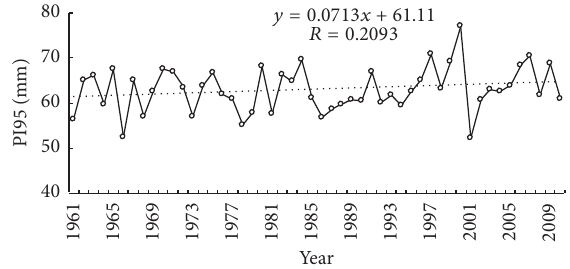
Figure 11: Temporal changes of PI95 in the Huaihe River basin.